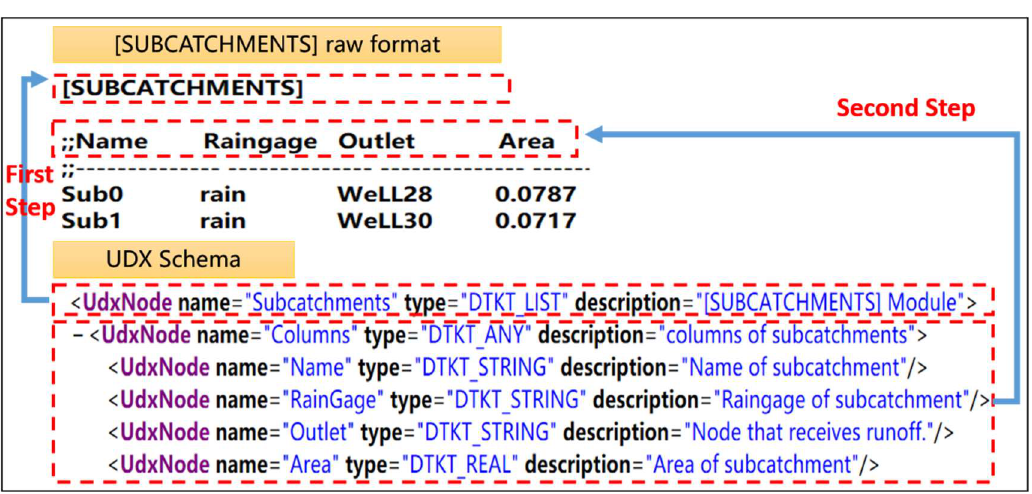
Figure 9. Universal Data eXchange (UDX) representation of the SWMM raw data format.